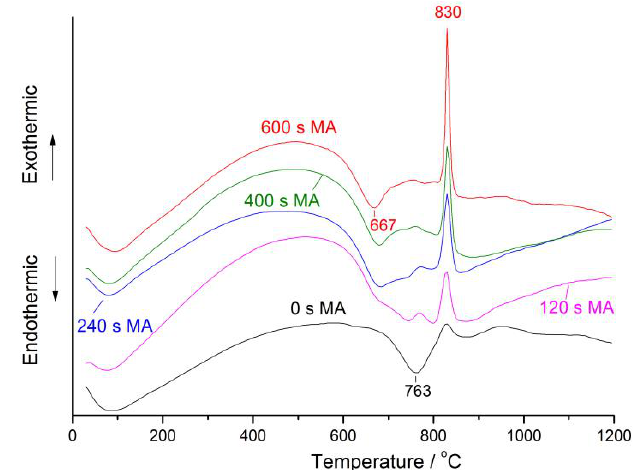
Figure 4. Differential thermal analysis curves for initial antigorite (0 s MA) and mechanically-activated (MA) antigorite (moderate mechanical activation in air).